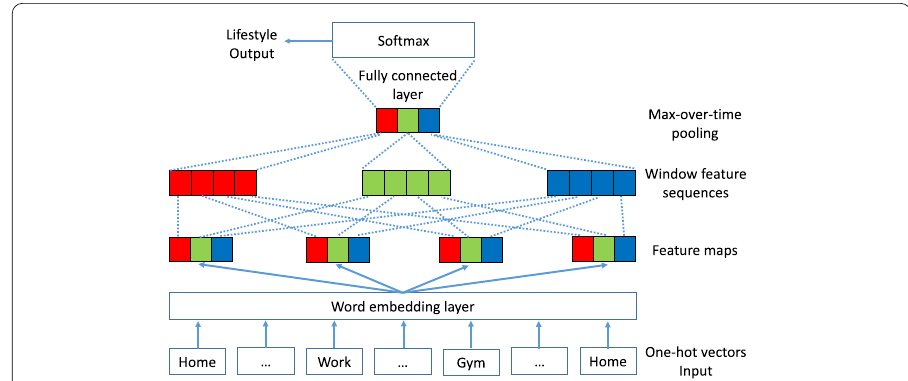
Figure 8 Predicting with CNN. The CNN model for predicting a lifestyle to trajectory. A one-hot vector has zeros for all trajectories except the specific trajectory (which is one). Each feature in a feature map is represented in a different color (could have more than three features)